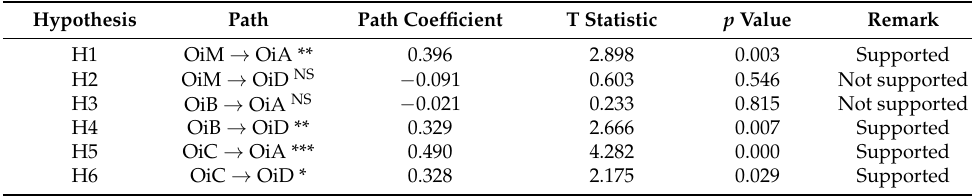
Table 6. Analysis of the significance of relationships. Hypothesis